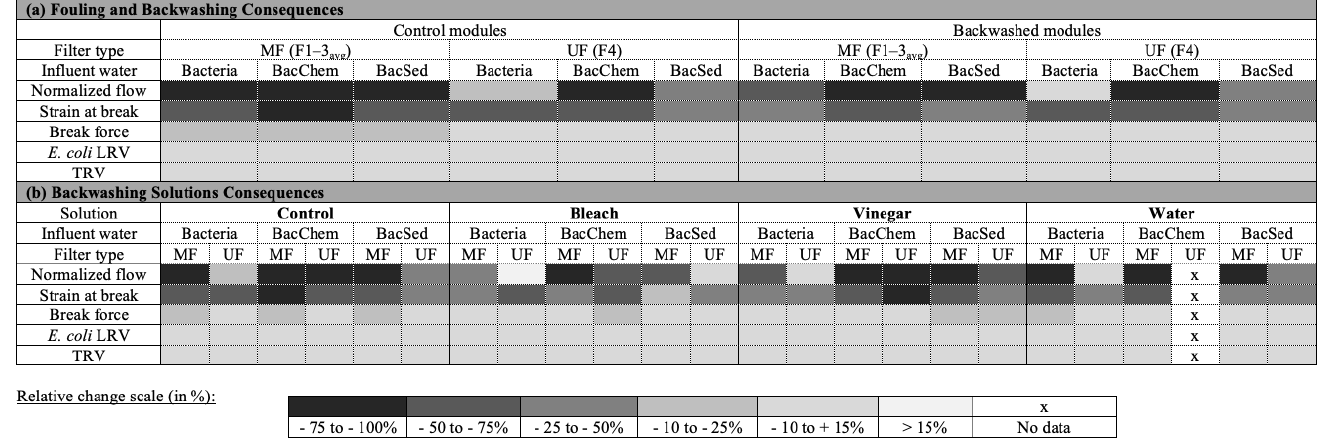
Figure 5. Relative change of indicators from baseline to endline (%, semiquantitative scale) for ( a ) control modules (fouling consequences) and backwashed modules (backwashing consequences) and ( b ) backwashed modules by backwashing solutions (backwashing solution consequences).